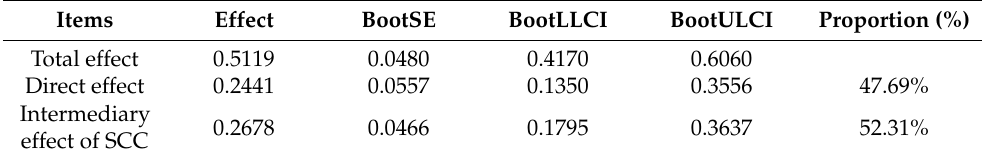
Table 8. Breakdown of total effect, direct effect and intermediary effect.